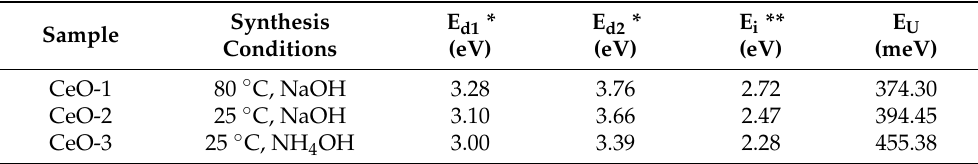
Table 3. Parameters extracted from Tauc and Urbach equations for cerium oxide nanoparticles. Sample